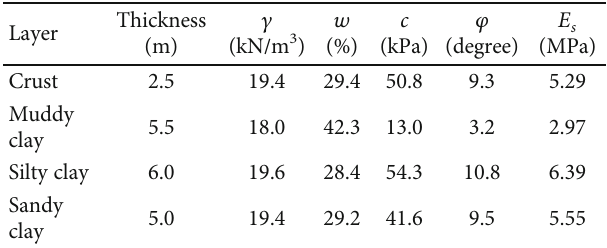
Table 5: Main soil properties at test sections in Huangpu